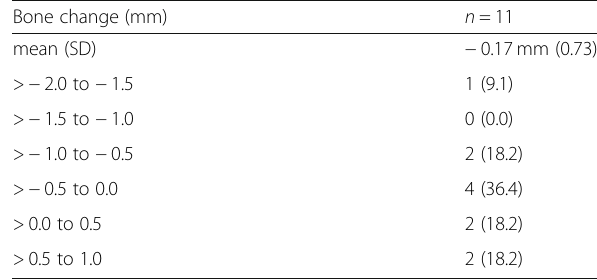
Table 4 Mean value, standard deviation, and frequency distribution (percentages) of marginal bone change between 1 month after restoration placement (T 1 ) and 1 year in function